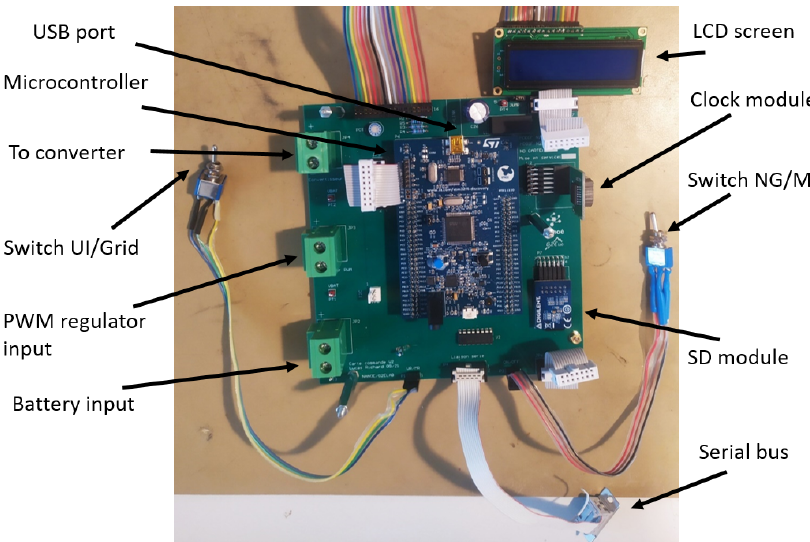
Figure 26. Command card of the interconnection